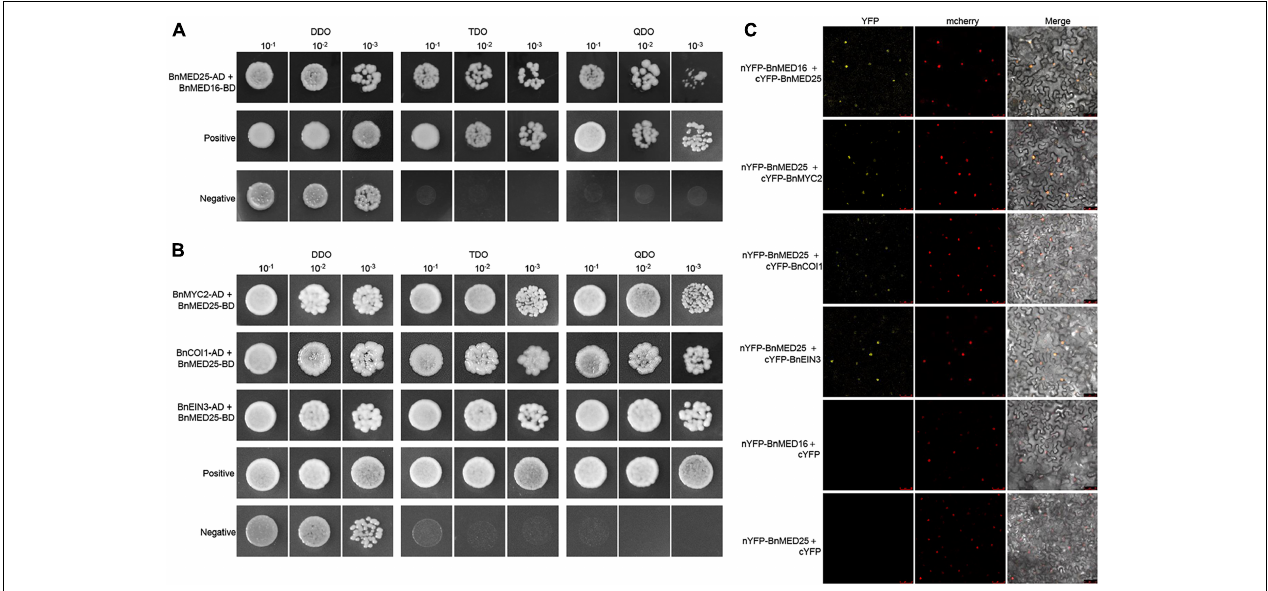
FIGURE 5 | Physical association between B. napus mediator and JA/ET-regulated proteins. (A) Yeast two-hybrid assays showing the interaction between BnMED16 and BnMED25. (B) Yeast two-hybrid assays showing the interaction between BnMED25 and BnMYC2, BnMED25 and BnCOI1, BnMED25, and BnEIN3. Transformed yeast cells were grown on SD media, and the colonies on TDO and QDO media indicate positive interactions. The positive control was pGADT7-RecT + pGBKT7-53 and the negative control was pGADT7-RecT + pGBKT7-lam. DDO, SD-Trp-Leu media; TDO, SD-Trp-Leu-His; QDO, SD-Trp-Leu-His-Ade; BnMED25-AD, pGADT7-BnMED25; BnMYC2-AD, pGADT7-BnMYC2; BnCOI1-AD, pGADT7-BnCOI1; BnEIN3-AD, pGADT7-BnEIN3; BnMED16-BD and BnMED25-BD, pGBKT7-BnMED16 and pGBKT7-BnMED25. (C) BiFC assay showing that the interaction between nYFP-BnMED16 and cYFP-BnMED25, nYFP-BnMED25, and cYFP-BnMYC2, nYFP-BnMED25 and cYFP-BnCOI1, nYFP-BnMED25 and cYFP-BnEIN3 formed a functional YFP in the nucleus. mCherrey served as a nucleus marker. Merge = merging of YFP and mCherrey. The interactions between nYFP-BnMED16 and cYFP, nYFP-BnMED25 and cYFP were used as negative controls for the BiFC assay. Bars, 50 µ m. All the experiments were repeated at least three times with similar